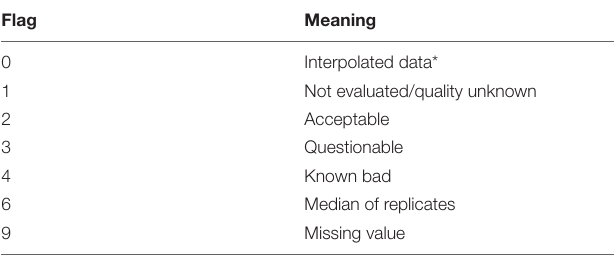
TABLE 2 | Consolidated primary level quality control (QC) flags for chemical oceanographic data documentation.